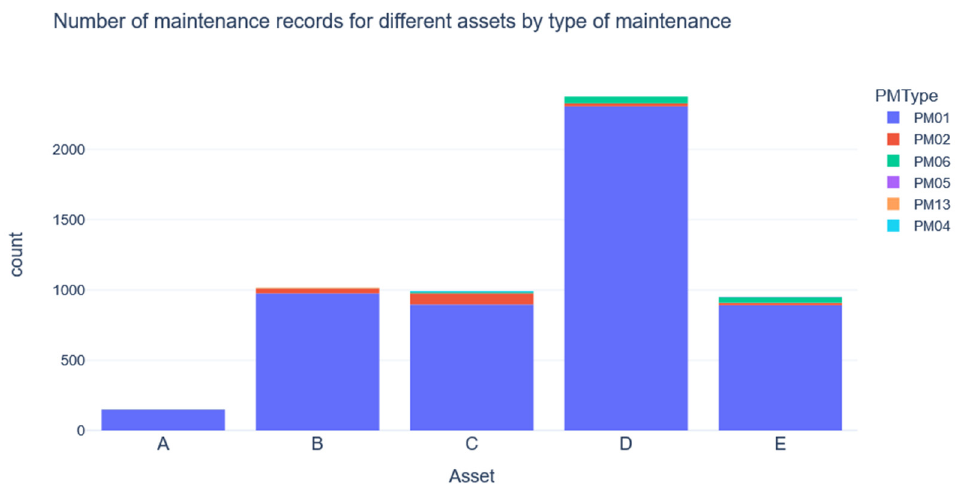
Figure 2. Maintenance type for different